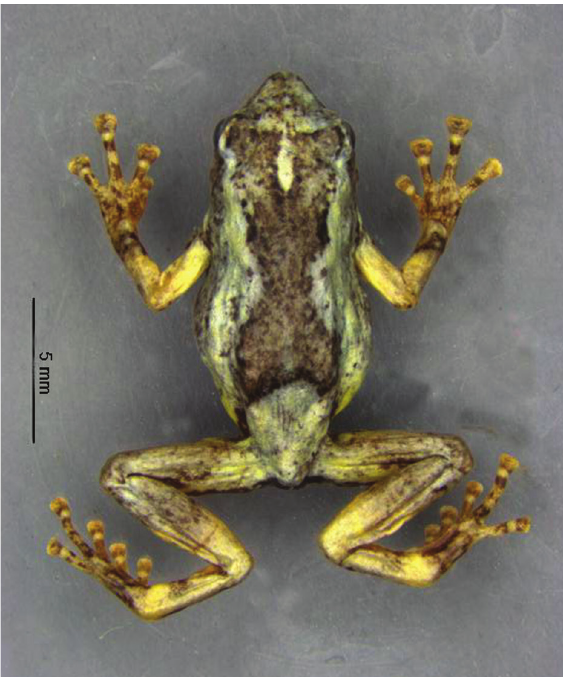
Figure 1b. Preserved holotype of Choerophryne crucifer sp. n. in ventral